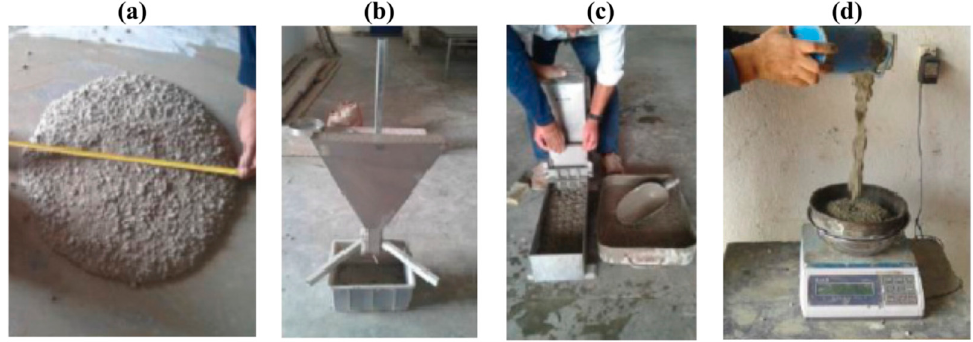
Figure 5. Characterization tests of SCC. ( a ) Slump flow test, ( b ) V-funnel test, ( c ) L-box test, ( d ) Sieve stability test.